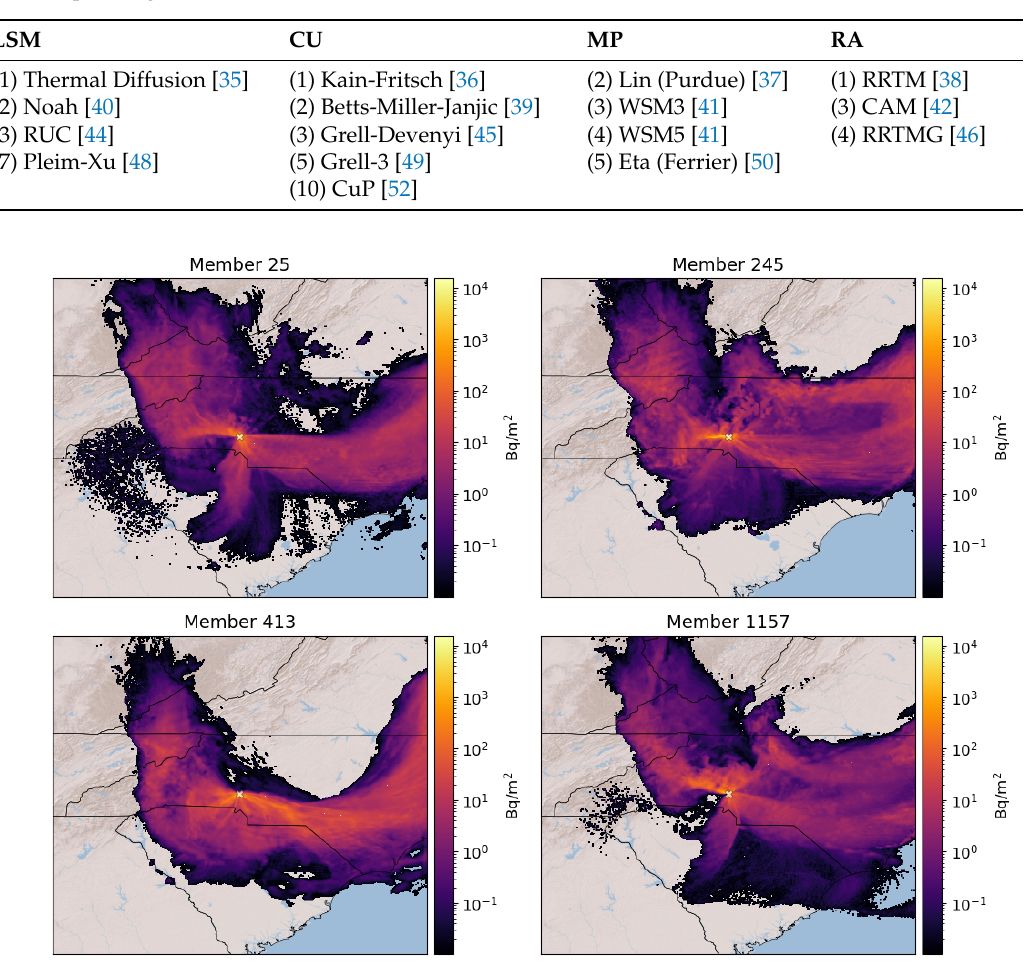
Table 2. WRF parameterizations used to create dataset, referred to here by their standard option number (between parentheses), name, and corresponding citation.